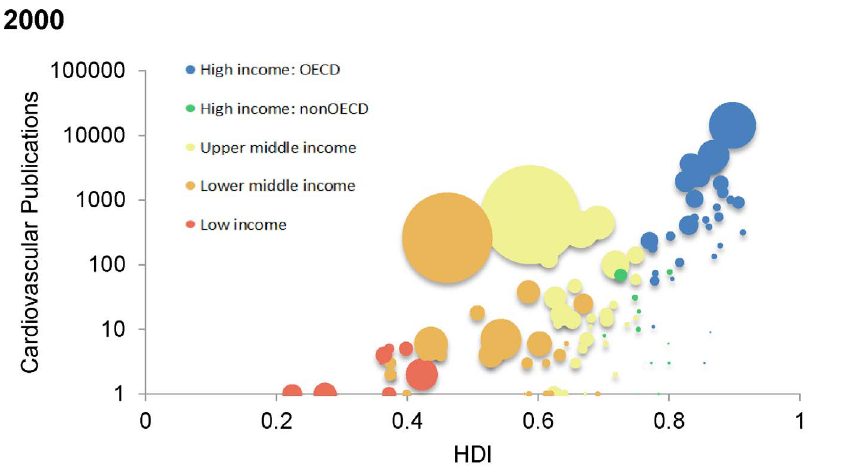
Figure 4. Country-level cardiovascular research publications against Human Development Index in 2000 (A) and 2008 (B). Color coding representing World Bank country income status. The size of each country’s bubble represents the population size of that country.